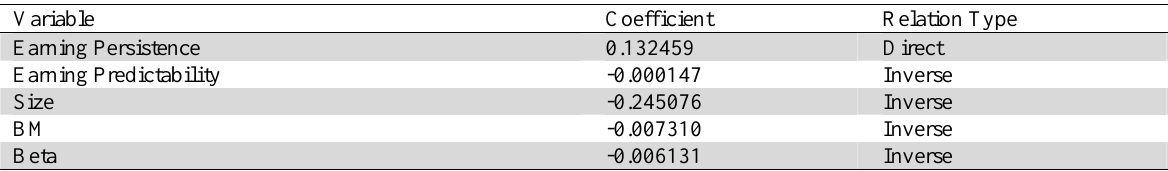
Variable Relation